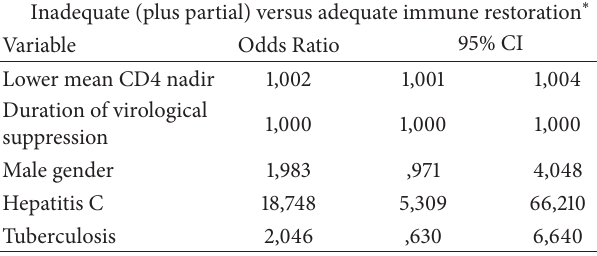
Table 4: Multivariate analysis of factors associated with different patterns of immune